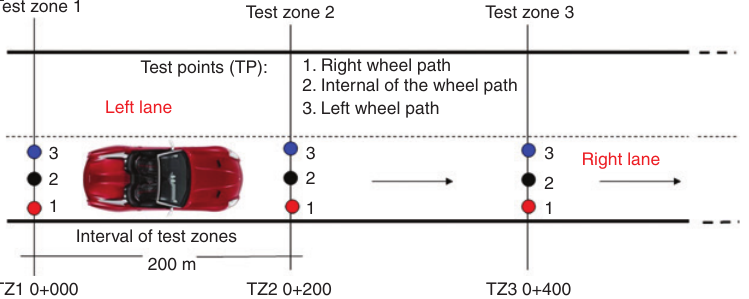
Figure 1: Schematic plan of nondestructive test